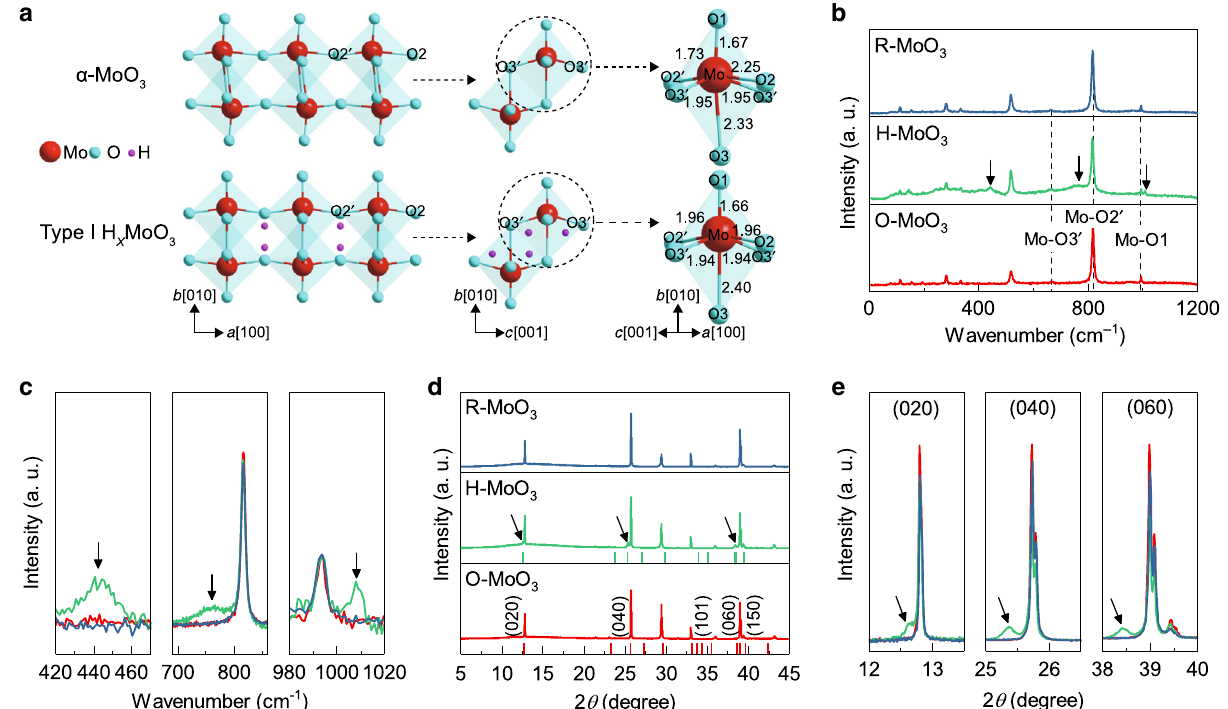
Fig. 1 Structural characterizations during the hydrogenation/dehydrogenation process. a Schematic illustrations of the crystal structures (linked double layers) and bond lengths (Å, ref. 28 ) of α -MoO 3 and type I H x MoO 3 . O1, O2 and O3 represent terminal oxygens, doubly coordinated bridging oxygens and triply coordinated oxygens, respectively. b Raman spectra of the original (O-MoO 3 ), hydrogenated (H-MoO 3 ), and recovered (R-MoO 3 ) α -MoO 3 . Black arrows indicate the vibration peaks that emerged after hydrogenation. c Magni fi ed Raman spectra (normalized) of O-MoO 3 , H-MoO 3 , and R-MoO 3 in b . d XRD pattern of the original, hydrogenated and recovered α -MoO 3 . Red and green tick marks represent the peaks in ICDD PDF card no. 05 – 0508 and 70 – 0615, respectively. Black arrows indicate the diffraction peaks originating from type I H x MoO 3 . e Comparison of the (020), (040), and (060) diffraction peaks (normalized) in d